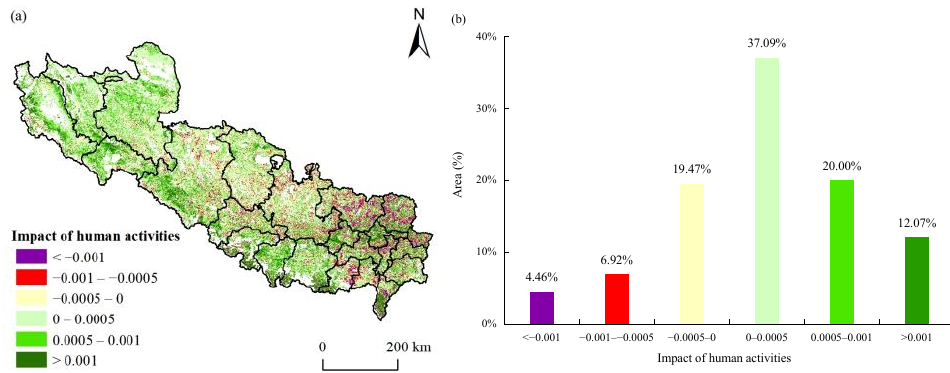
Figure 7. Spatial distribution of human activities on the vegetation change ( a ) and area proportion ( b ) in the SWTP from 2000 to 2020. ( b ) in the SWTP from 2000 to